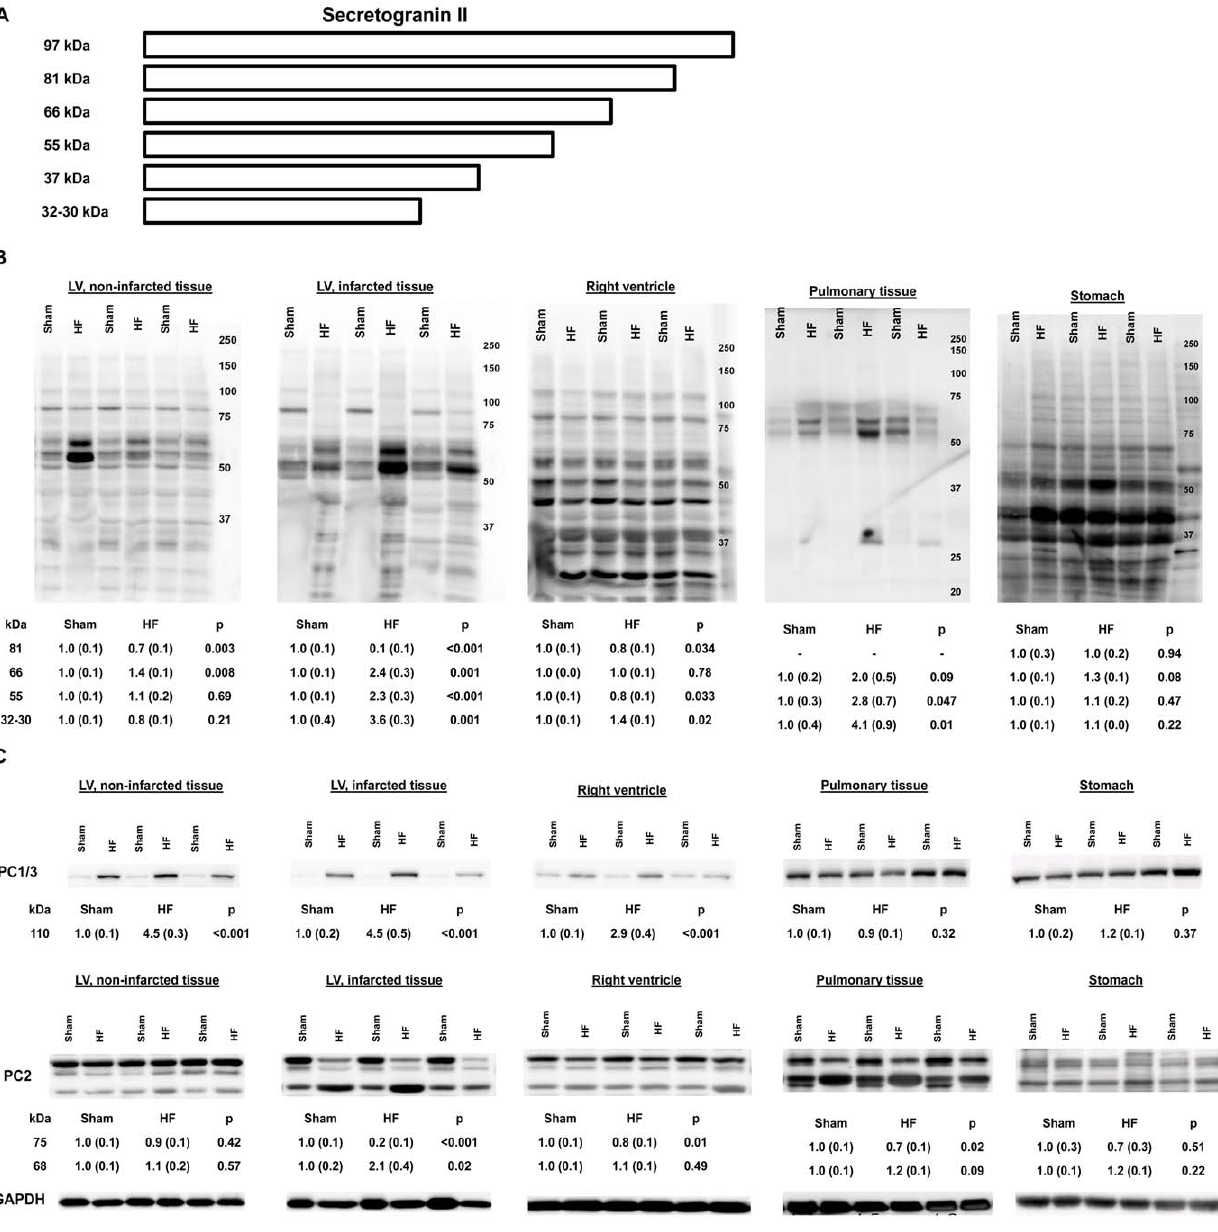
Figure 3. SgII processing is increased in the myocardium of HF mice. A, Figure of SgII processing as reported in non-cardiac tissue (modified from ref. 18). B, SgII processing in myocardial tissue, pulmonary tissue, and tissue from the stomach. Bands at 81, 66, 55, and 32-30 kDa were measured and are presented as fold change (SEM) vs. sham animals (n=6 for each group). C, Levels of the proteases PC1/3 and PC2 in HF and sham animals.